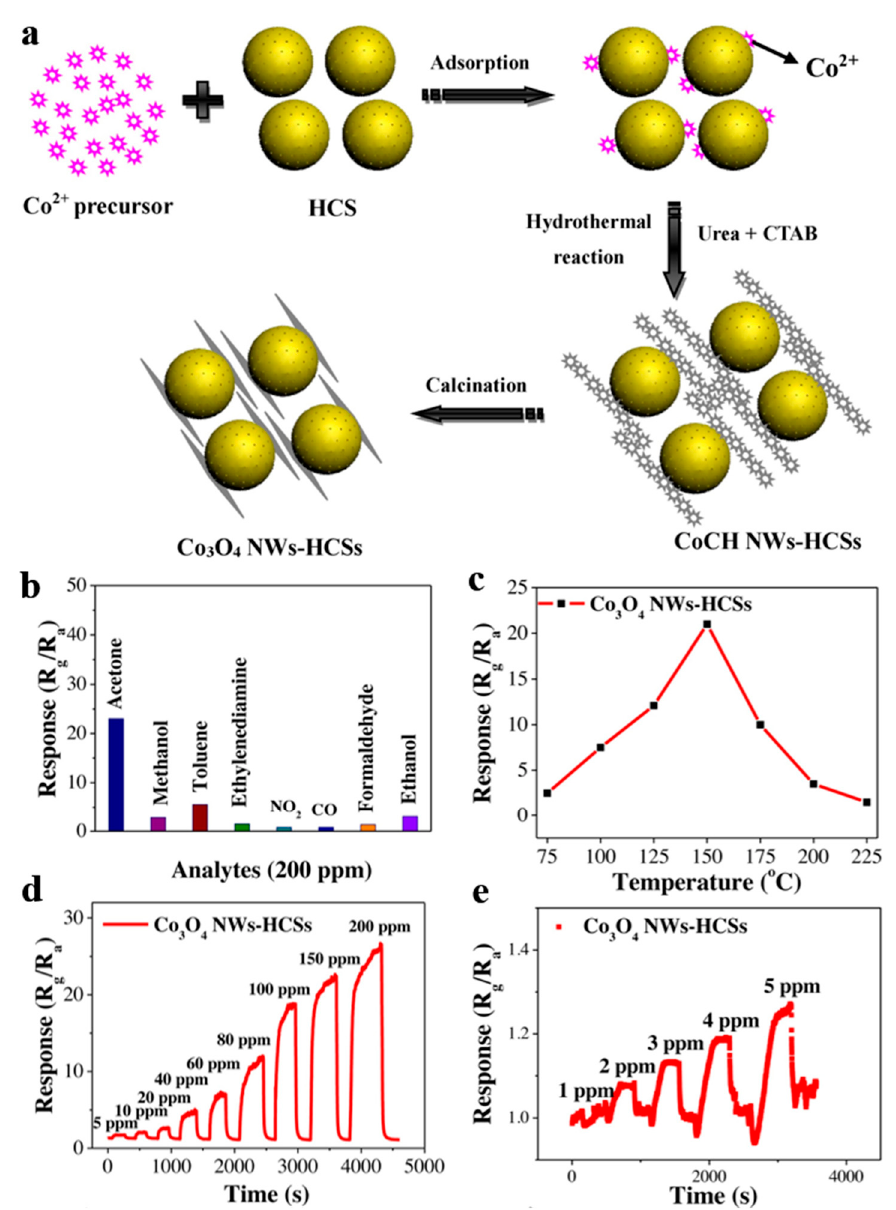
Figure 22. ( a ) Synthetic Schematic of Co 3 O 4 NWs-HCSs. The gas-sensing performance of Co 3 O 4 NWs-HCSs. ( b ) Sensing selectivity for several 200 ppm gases at 150 ◦ C. ( c ) Sensing response versus operating temperature to 200 ppm acetone. ( d , e ) Dynamic sensing response to acetone within di ff erent concentration ranges at the operating temperature of 150 ◦ C. Reproduced with permission from